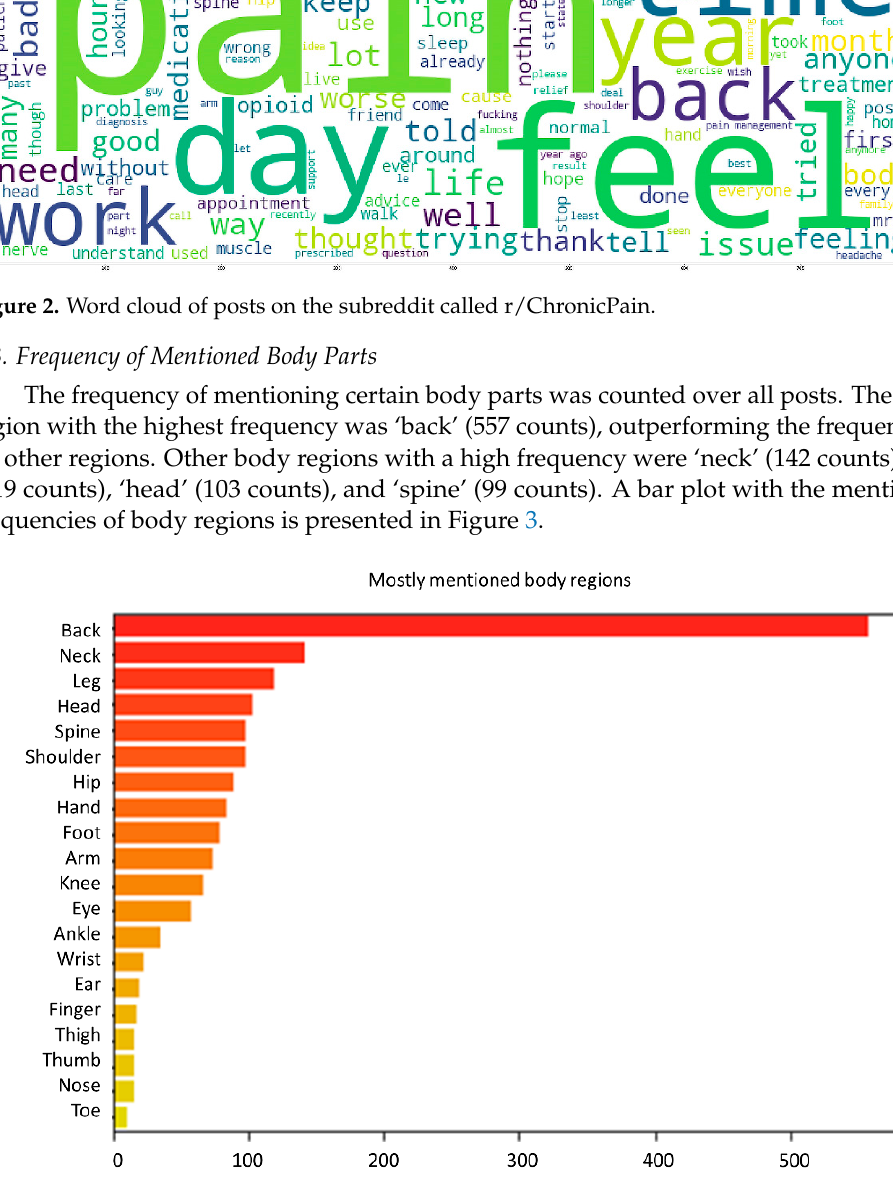
Figure 3. Bar plot presenting the frequency with which body regions were mentioned in posts.